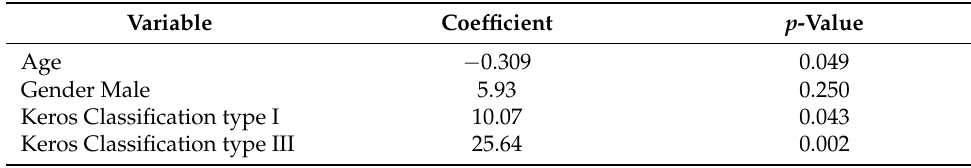
Volume (mm 3 ). Table 6. Estimation of the regression coefficient and p -value of the GEE model to assess the influence of age and gender and Keros classification on the volume of the frontal septal cell.